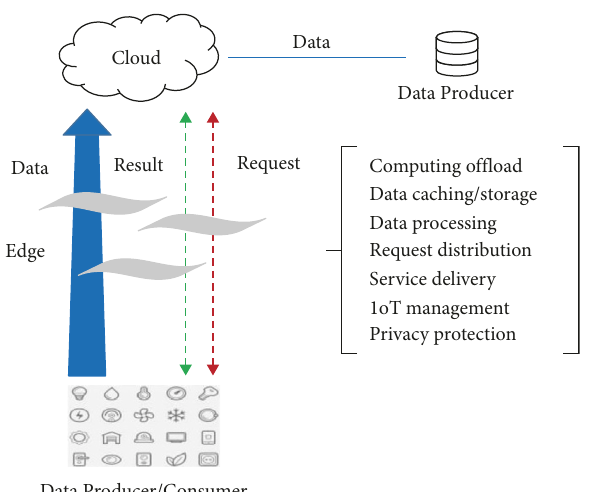
Figure 2: Data interaction mode of an integrated processing method based on edge